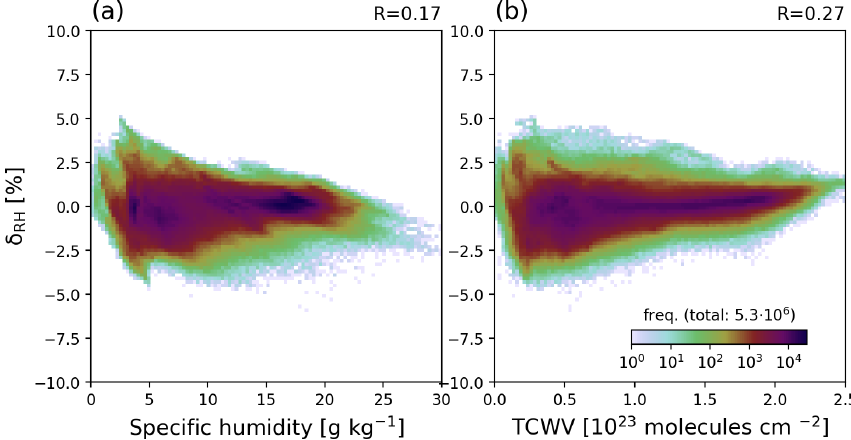
Figure 10. Deviation δ RH according to Eq. (19) as function of (a) specific humidity at ground, and (b) TCWV for ERA5 simulations on 18 June 2018. Temperature inversions with T max − T 0 > 2K have been